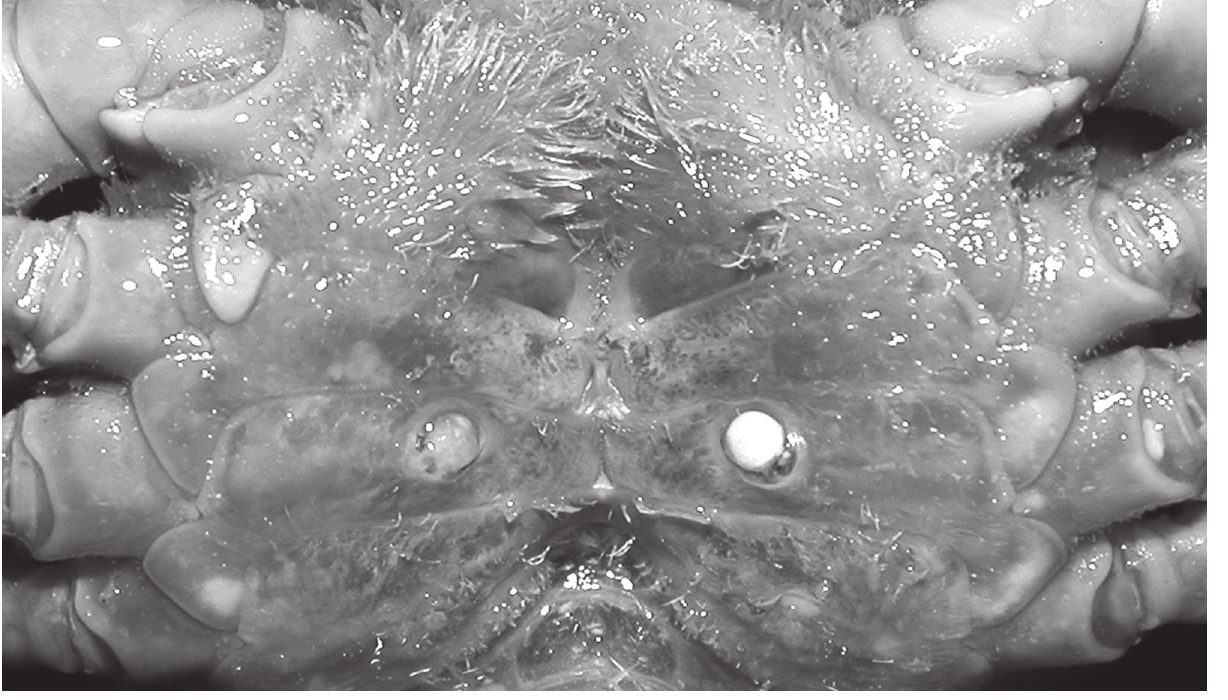
Figure 5. Sundathelphusa tuerkayi , new species, paratype, female (38.0 × 29.4 mm) (SMF 1800), Lombok, Indonesia; thoracic sternum showing